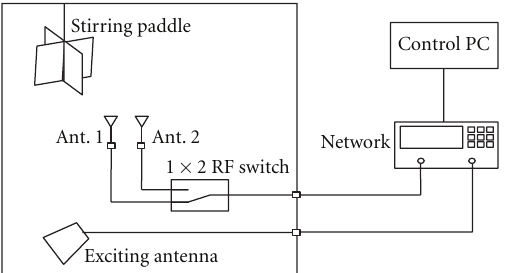
Figure 1: Scheme of the reverberation chamber measurement setup.